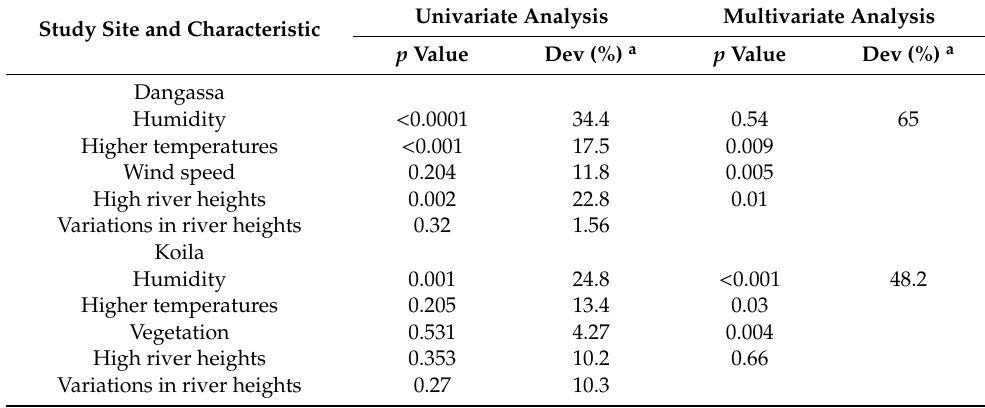
Table 1. Dangassa and Koila-univariate and multivariate analysis. Univariate Study Site and Characteristic